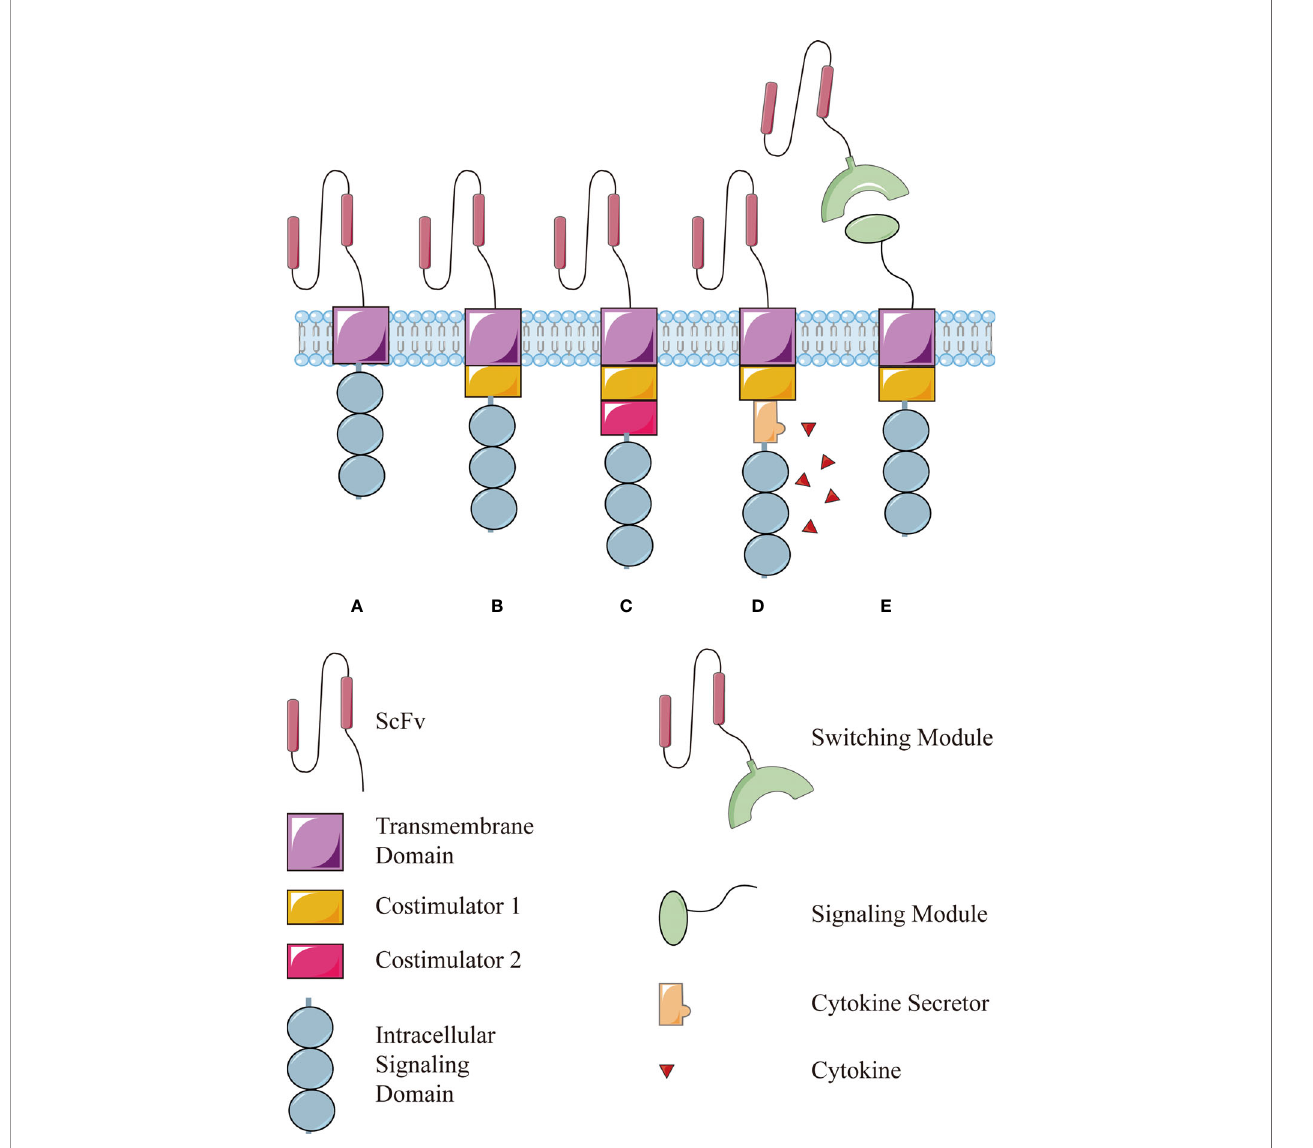
FIGURE 1 | The structure of conventional CAR and modular CAR: (A) the fi rst generation of CAR consists of an extracellular antigen-binding domain (usually the single chain variable fragment, scFv), a transmembrane domain, and an intracellular signaling domain of the CD3 z chain. Then, a costimulator is added in the (B) second generation and more in the (C) third generation. (D) The fourth generation of CAR is modi fi ed further to secret a cytokine to enhance the function. (E) The modular CAR is split into two interactive parts, the signaling module on T cells and the switching module to recognize